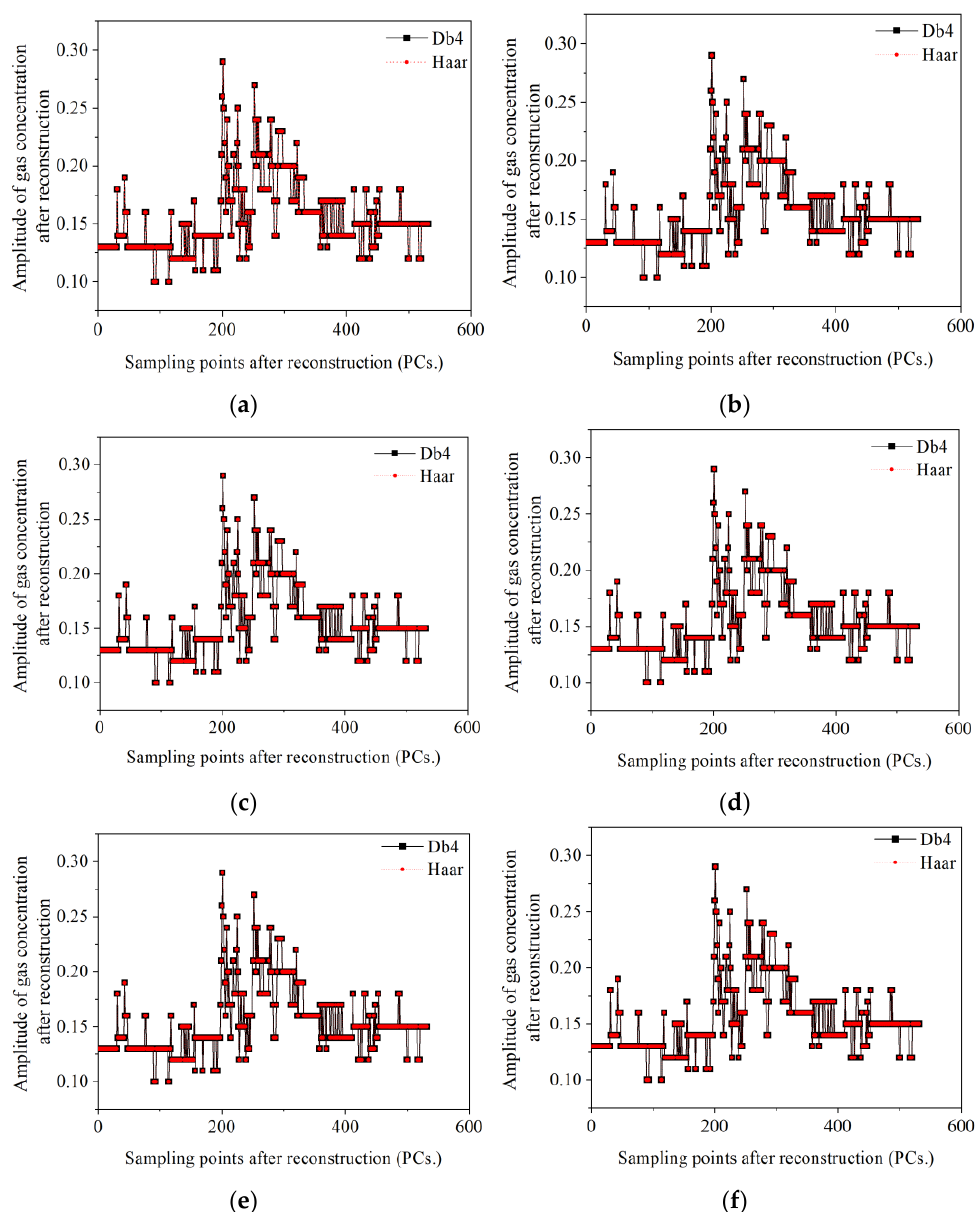
Figure 9. Multi-level wavelet reconstruction signal. ( a ) Level-1 reconstruction, ( b ) Level-2 recon- struction, ( c ) Level-3 reconstruction, ( d ) Level-4 reconstruction, ( e ) Level-5 reconstruction, and ( f ) Level-6 reconstruction.